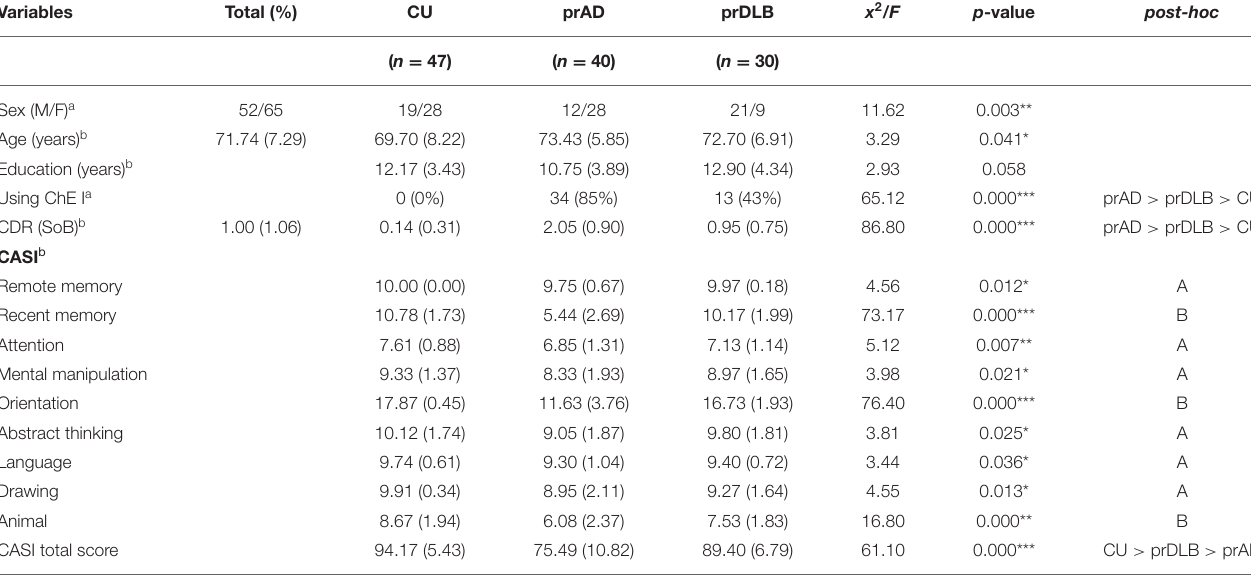
TABLE 1 | Demographic characterization and CASI.